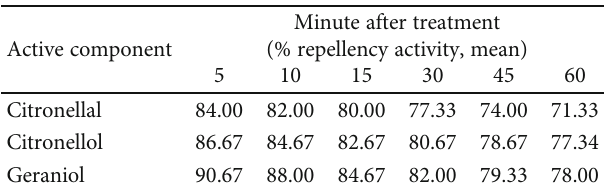
Table 2: The mosquito repellent activity of three major compounds isolated from C. winterianus